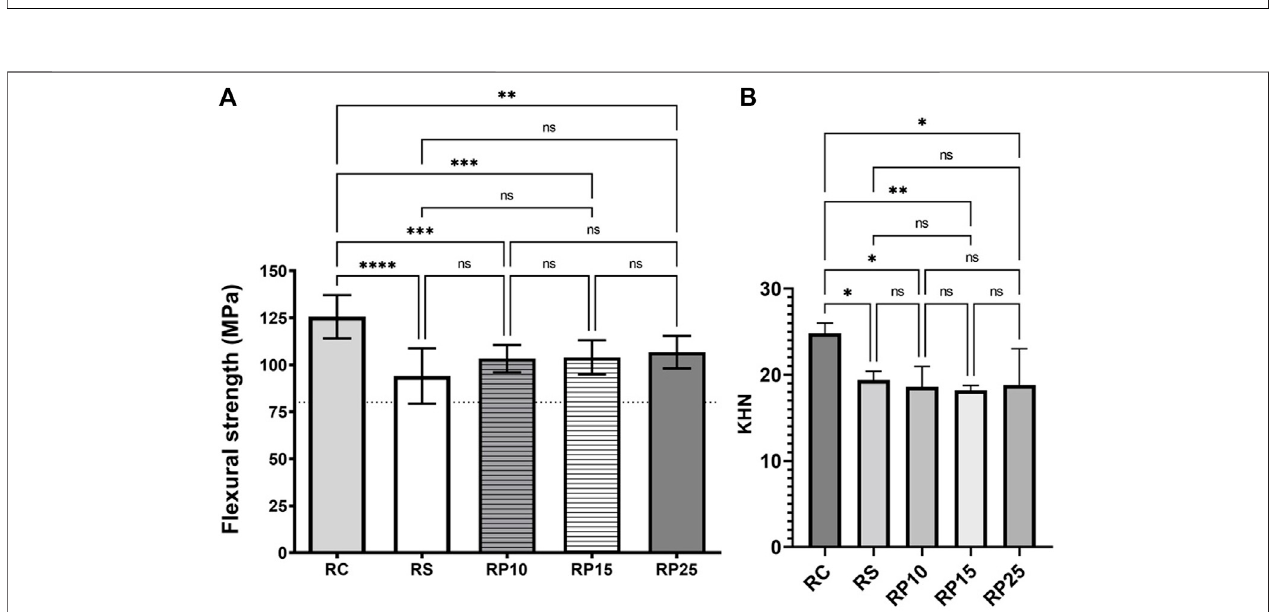
FIGURE 5 | Mechanical characterization of EABRP enriched composite resin. (A) : Flexural strength determination (MPa). Dot line: minimal limit of 80 MPa (ISO 4049). (B) : Knoop microhardness. RC, commercial resin; RS, commercial resin + HEMA solvent; RP10, RP15 and RP25, enriched EABRP composite resins at 0.10, 0.15 and 0.25%